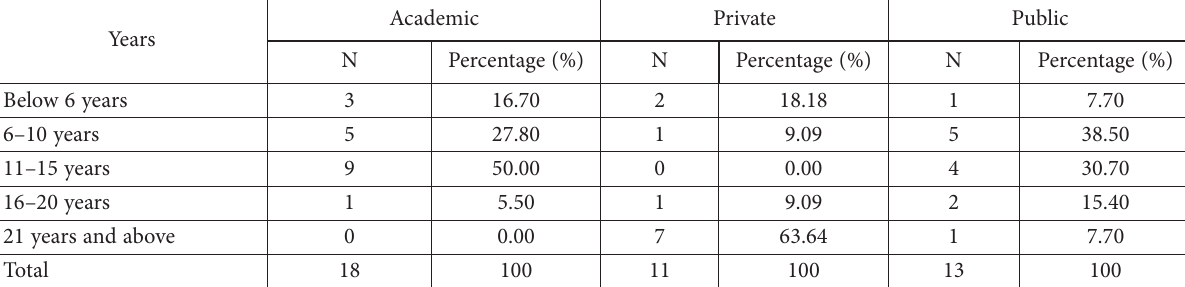
Table 3. Experts’ working/research experience in PPPs (Osei-Kyei & Chan, 2017)